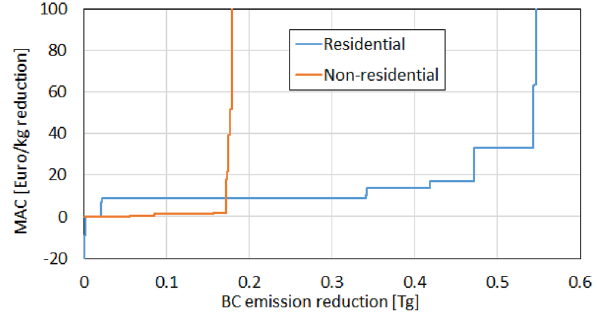
Figure 4. Marginal abatement cost (MAC) curves for Chinese BC emissions from residential and non- residential